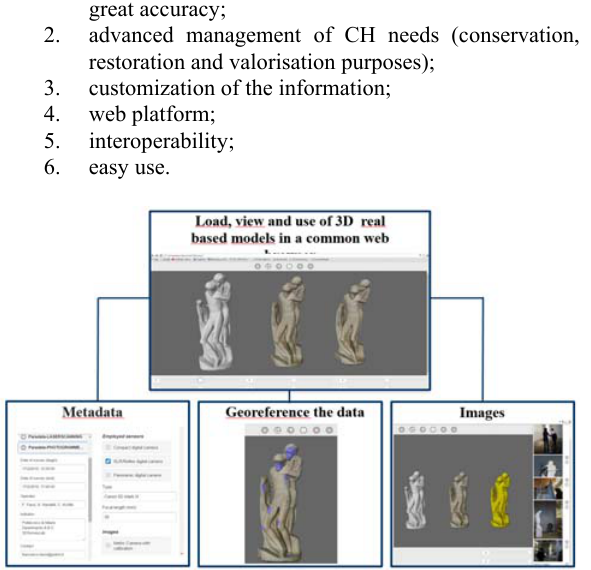
Figure 12. General features of BIM3DSG.